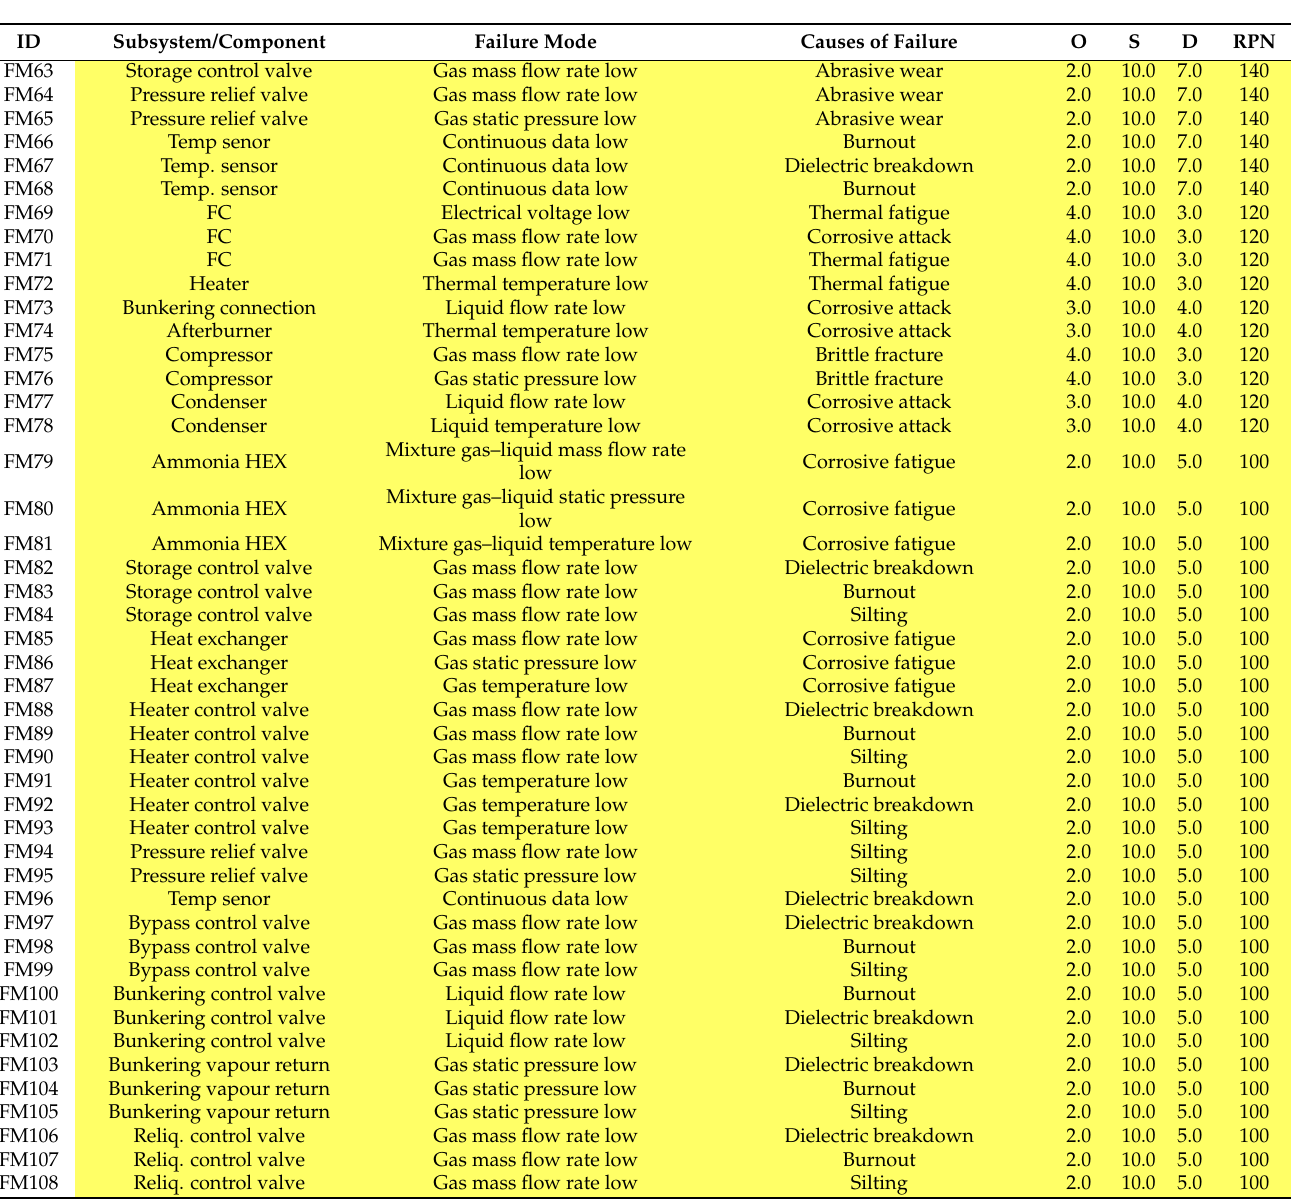
Colour code: Red: High importance, Orange: moderate high, Yellow: